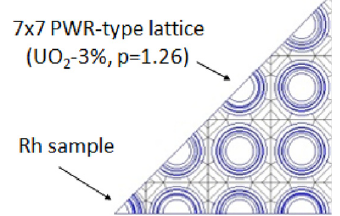
Fig. 1. Geometrical model of the numerical